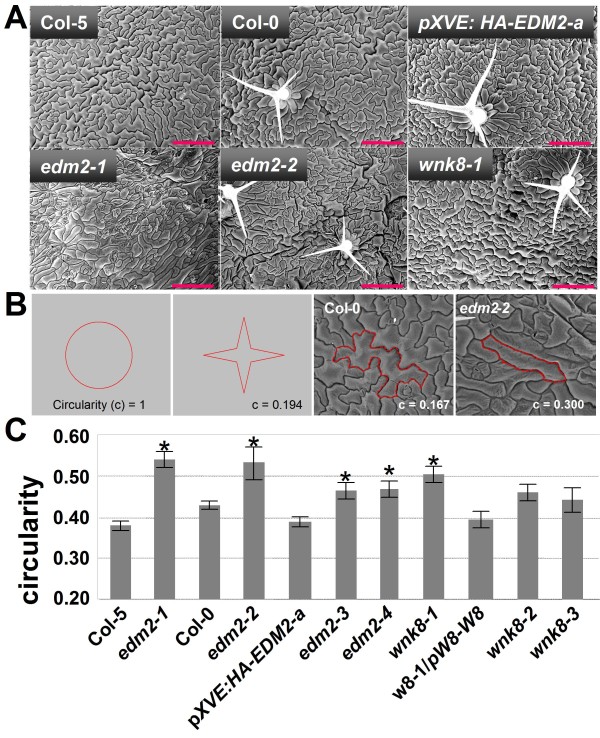
EDM2 and WNK8 are required for leaf pavement cell development. A: Scanning electron microscopy with adaxial surfaces of the 6th rosette leaves of the indicated Arabidopsis genotypes. 25 day-old plants grown under long-day conditions were used. The red scale bar represents 200 μm. pXVE:HA-EDM2-a plants were not treated with estradiol. B: Circularity [c = 4pi × (area/perimeter2)] as a numerical expression of cell shape. C: Average circularity values of 40 - 80 cells per genotype determined from the photos shown in (A) using ImageJ http://rsbweb.nih.gov/ij/. Significant deviations of values from the tested mutants to their respective wild type controls (Col-5 for edm2-1, Col-0 for all others) based on t-tests (p < 0.05) are denoted by asterisks.